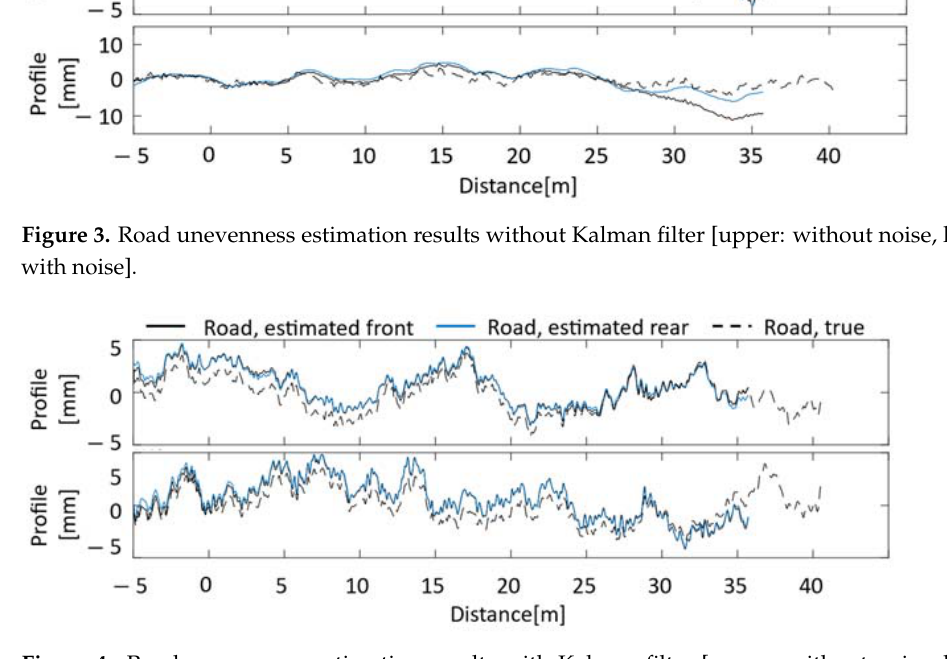
Figure 4. Road unevenness estimation results with Kalman filter [upper: without noise, lower: with noise].